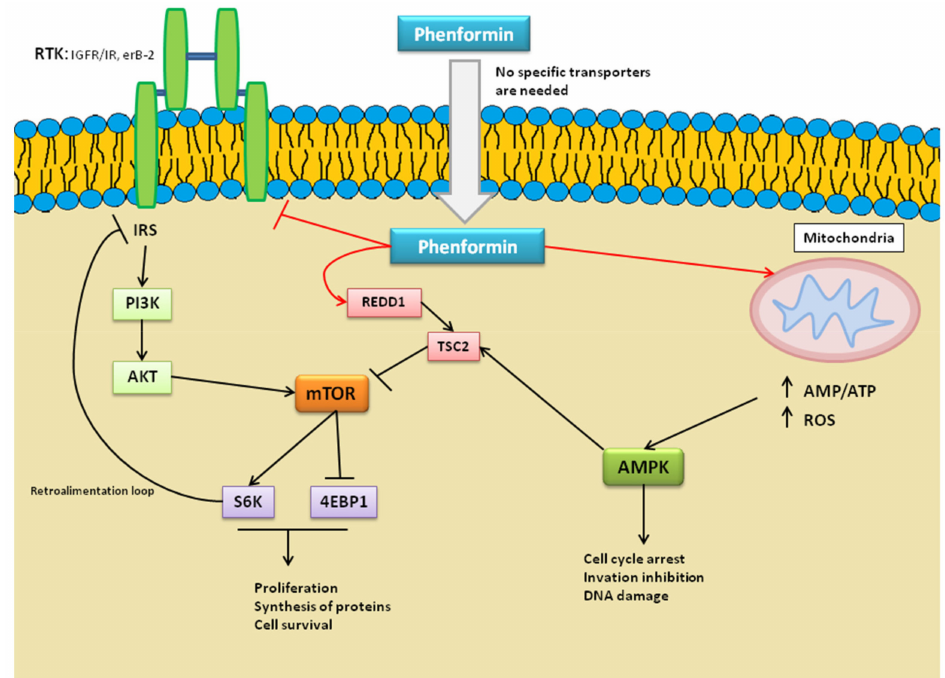
Figure 4. Mechanism of Action of Phenformin. When phenformin passes freely through the cellular membrane, it acts in three di ff erent ways: 1) inhibition of the complex I of the mitochondrial respiratory chain, 2) activation of REDD1 protein, 3) inhibition of insulin receptor substrate (IRS) receptors. These actions lead to AMP-activated protein kinase with energy detection (AMPK) activation and mTOR pathway blocking by the activation of its inhibitor and the retro-alimentation loop block. This process leads to cell cycle arrest, invasion inhibition, and DNA damage. It also blocks proliferation, synthesis of proteins, and cell survival. ROS, reactive oxygen species; RTK, receptor tyrosine kinase; IGFRs, insulin-like growth factors; EGFRs, epidermal growth factor receptors; IRS, insulin receptor